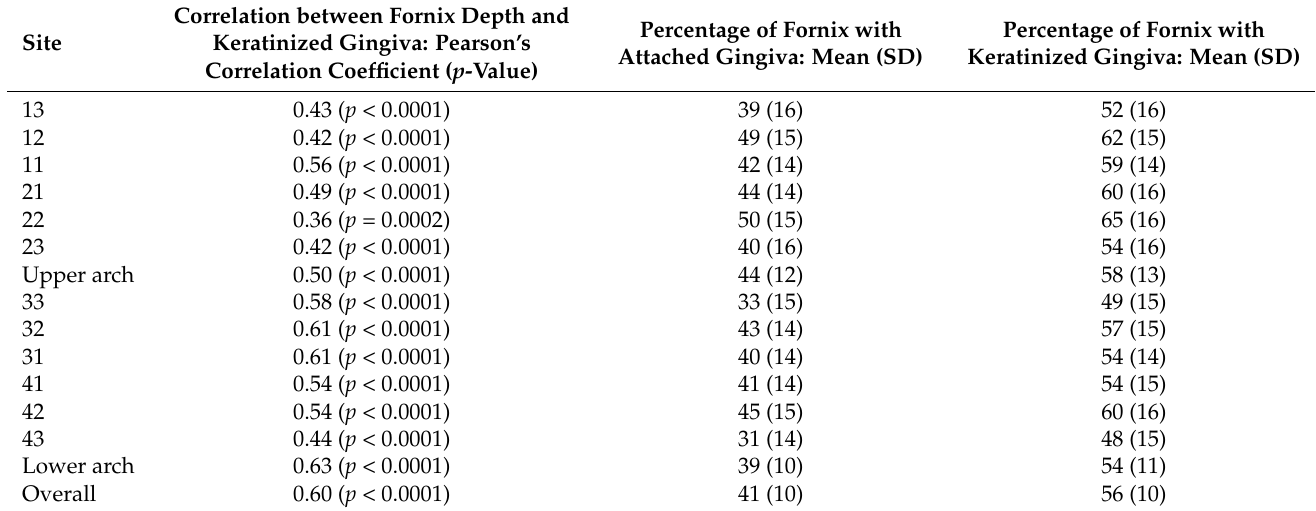
Table 1. Analysis of fornix depth, keratinized gingiva, and attached gingiva.